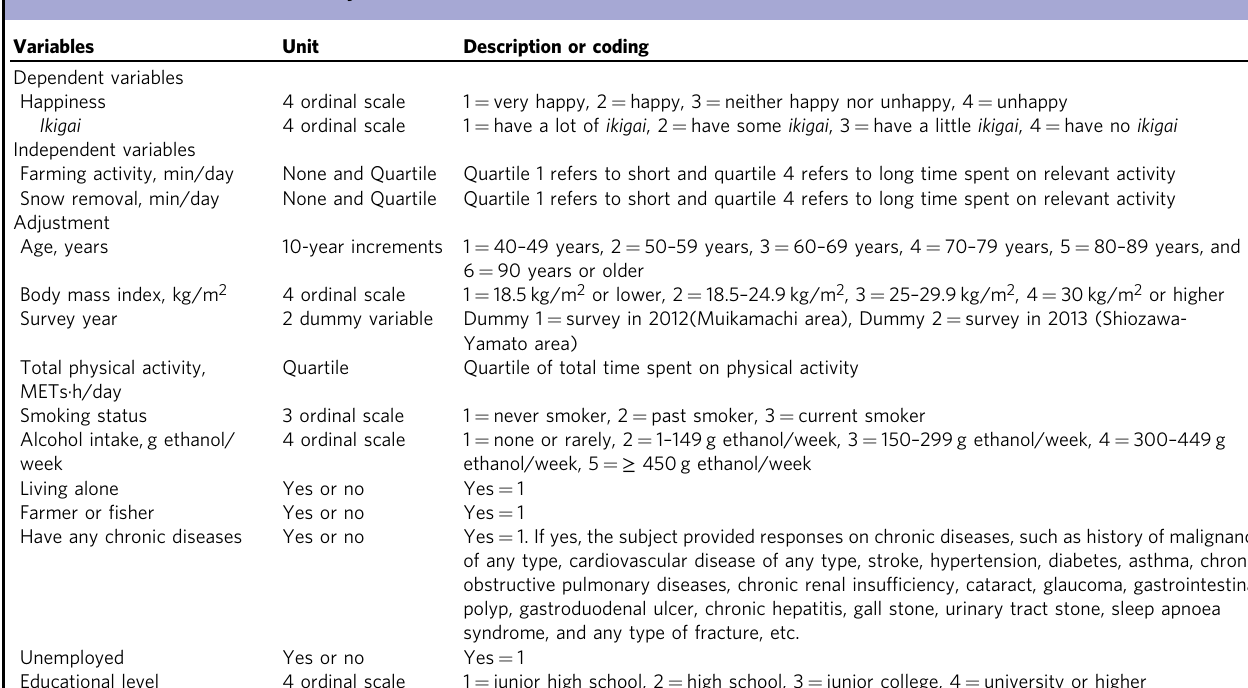
Table 1 Variables used in the